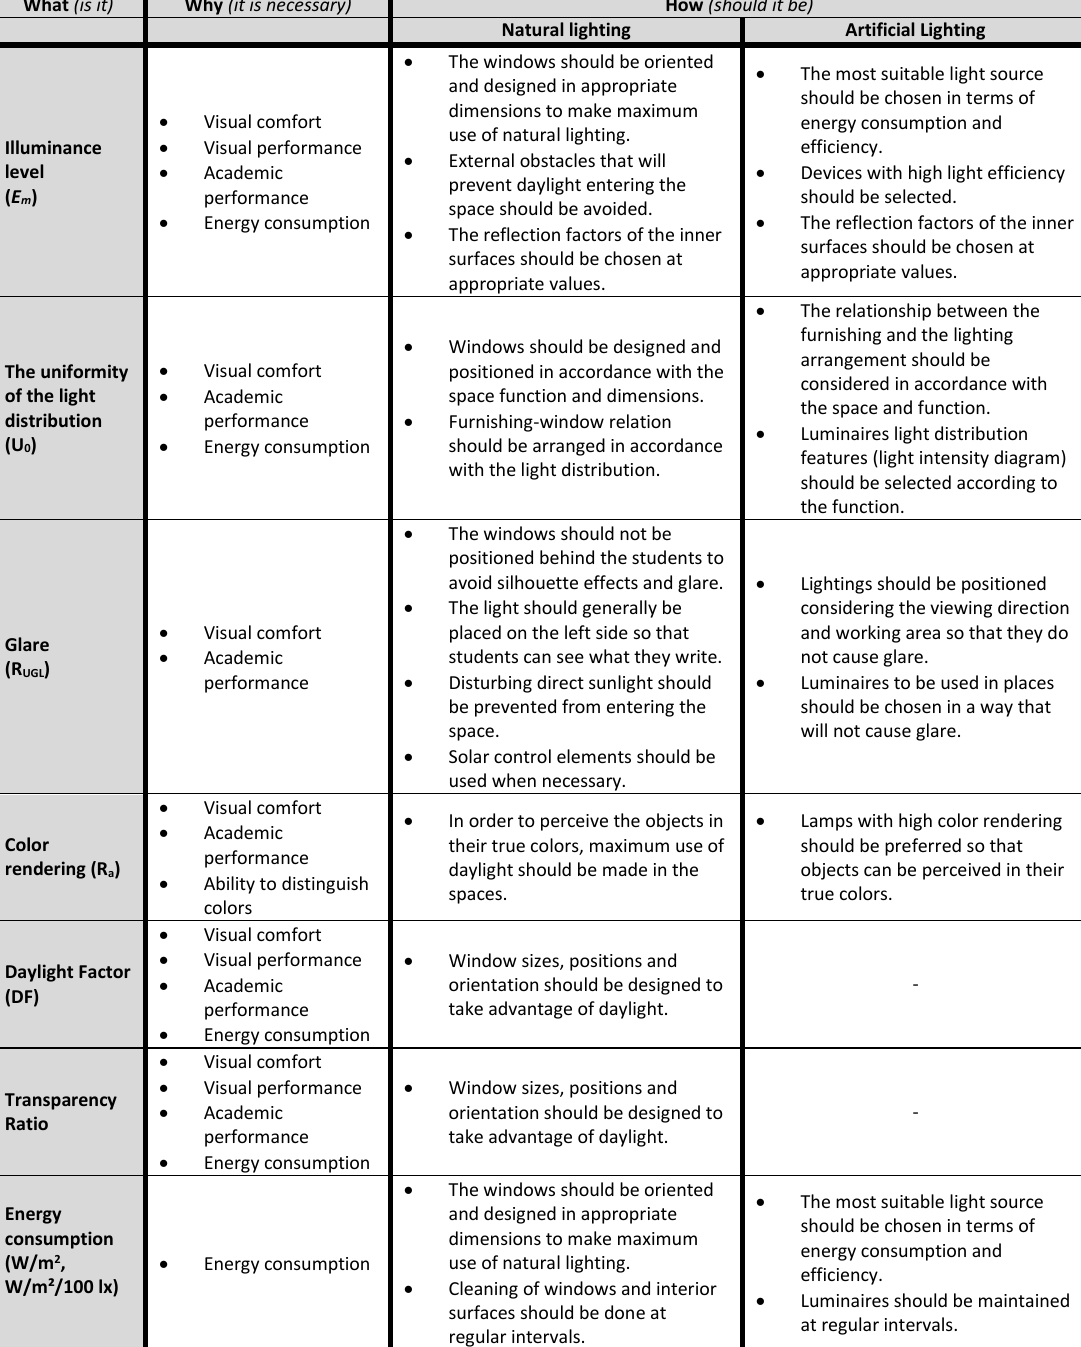
Table 4 General information on lighting design criteria in educational buildings (What-Why-How) What (is